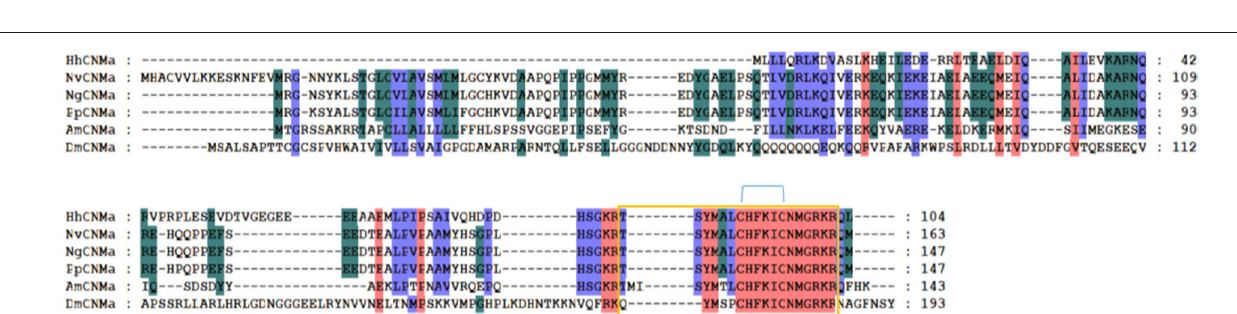
FIGURE 2 | Multiple sequence alignment of the bursicon alpha subunit (Bur α ) from H. hebetor (HhBur α ), D. melanogaster (DmBur α , CAH74223.1), C. suppressalis (CsBur α , ALM30306.1), Nilaparvata lugens (NlBur α , BAO00937.1), N. vitripennis (NvBur α , NP_001155852.1), Plutella xylostella (PxBur α , AJM76770.1), and T. castaneum (TcBur α , ABA40402.1). Amino acid residues common in at least four sequences are highlighted. Asterisks indicate those cysteine residues proposed to be involved in cycling bridges.